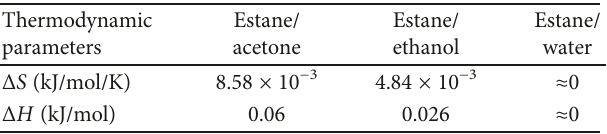
Table 3: Thermodynamic parameters for sorption in Estane and studied solvents.